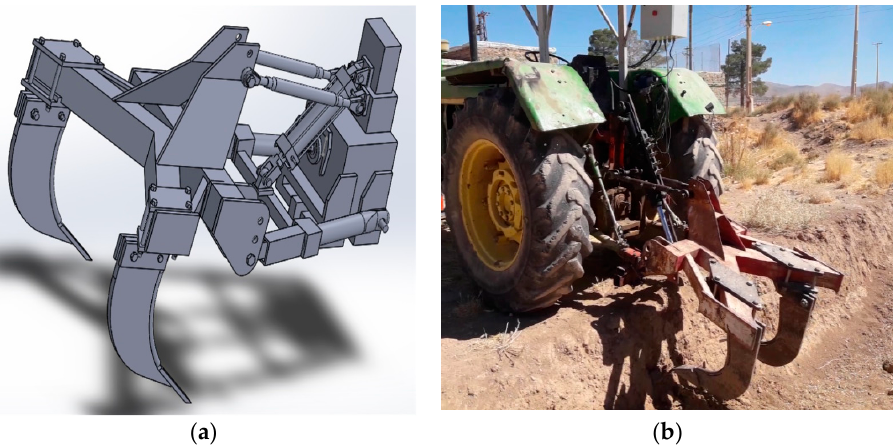
Figure 8. Subsoiler and the hydraulic system mounted on the tractor: ( a ) designed form, ( b ) real form at work at a depth of 40 cm on the platform.